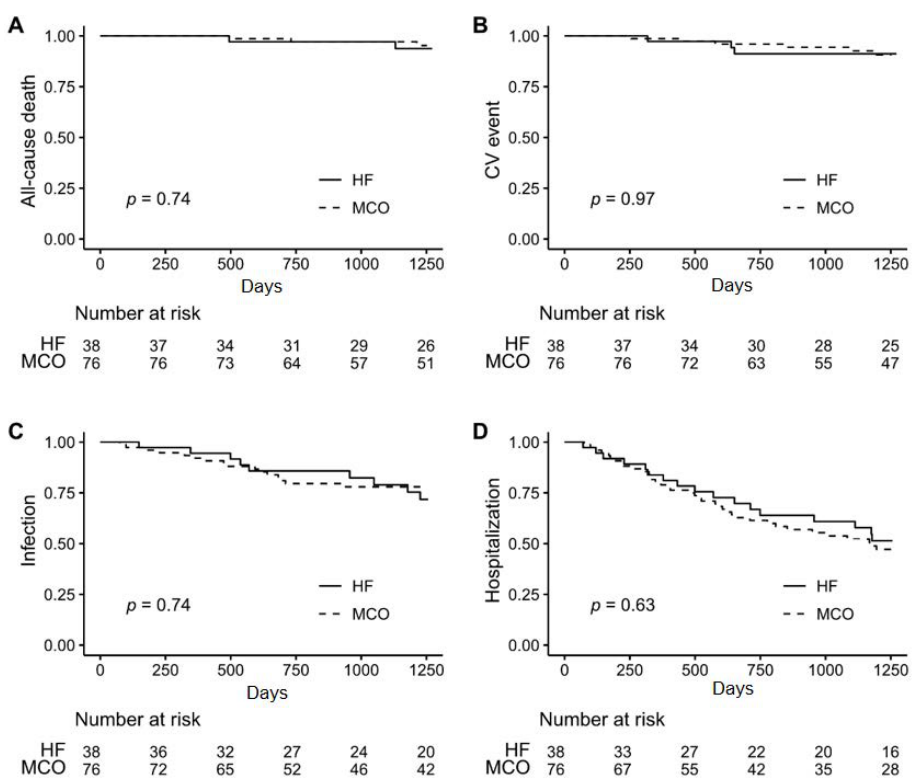
Figure 1. Clinical events occurrence according to the hemodialysis membrane types. Clinical outcomes included all-cause death ( A ), cardiovascular events ( B ), infectious events ( C ), and hospital- izations ( D ). HF, high-flux membrane; MCO, medium cut-off membrane; CV,